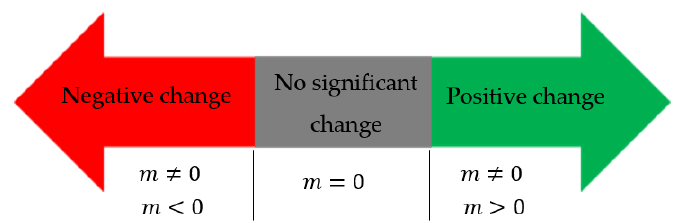
Figure 5. Classification intervals for selected profitability indicator. Source: own research .